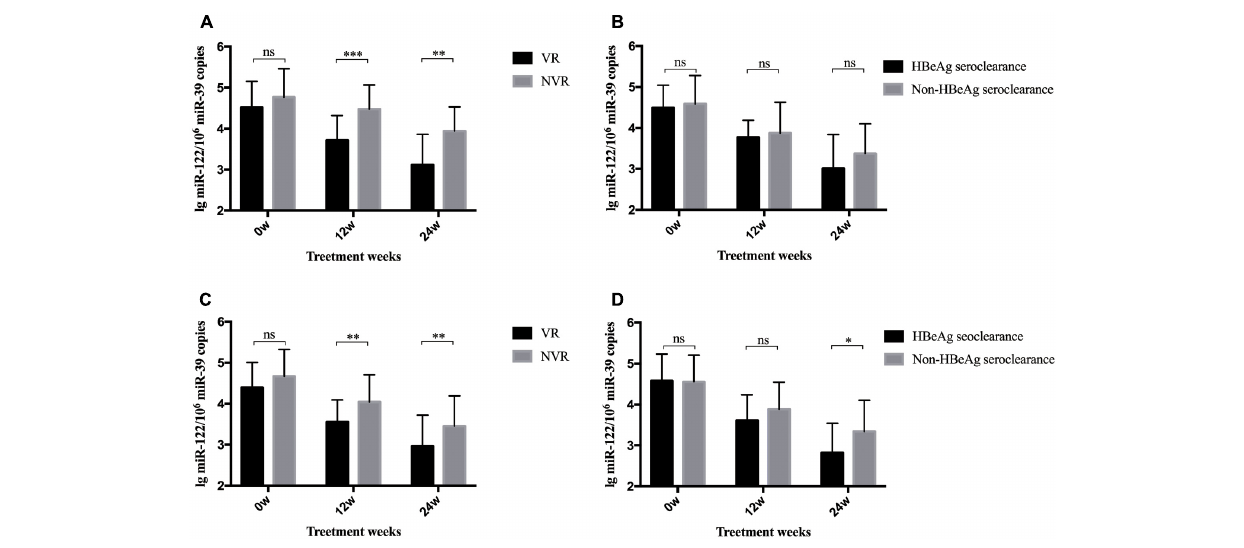
FIGURE 2 | Differential levels of serum miR-122 among subgroups. The bars represent the mean and standard error of mean. (A) MiR-122 levels in serum at baseline, week 12, and week 24 among patient groups whether a VR was achieved at week 96. (B) MiR-122 levels at baseline, week 12, and week 24 among patient groups whether HBeAg clearance was achieved at week 96. (C) MiR-122 levels in serum at baseline, week 12, and week 24 among patient groups whether a VR was achieved at week 48. (D) MiR-122 levels at baseline, week 12, and week 24 among patient groups whether HBeAg clearance was achieved at week 48. VR, virological response; NVR, non-virological response; ns, not significant; ∗ p < 0.05; ∗∗ p < 0.01; ∗∗∗ p < 0.001.